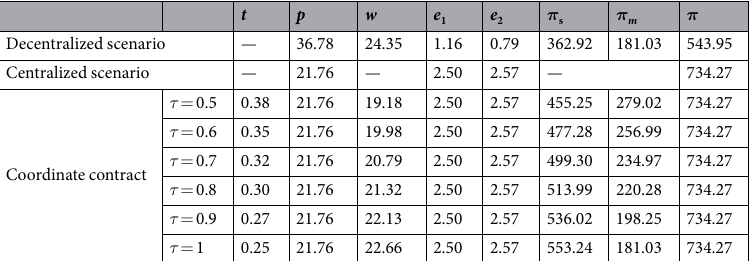
Table 2. The optimal results under different